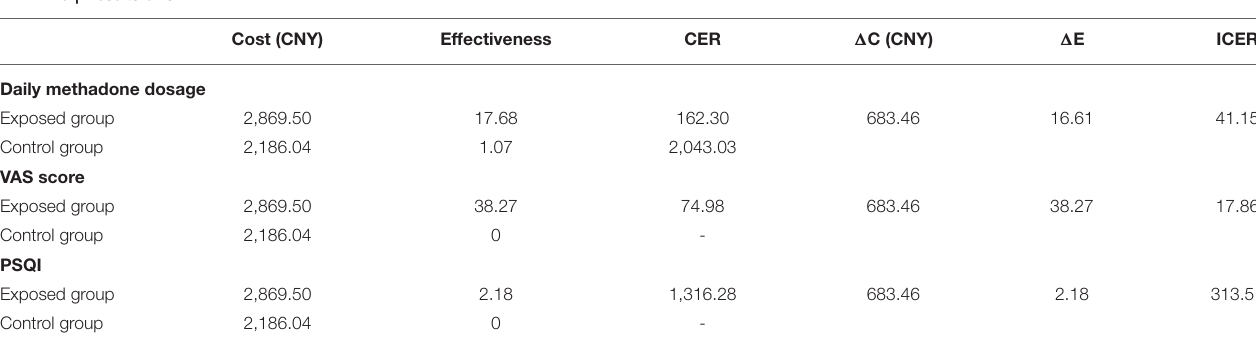
TABLE 5 | Results of